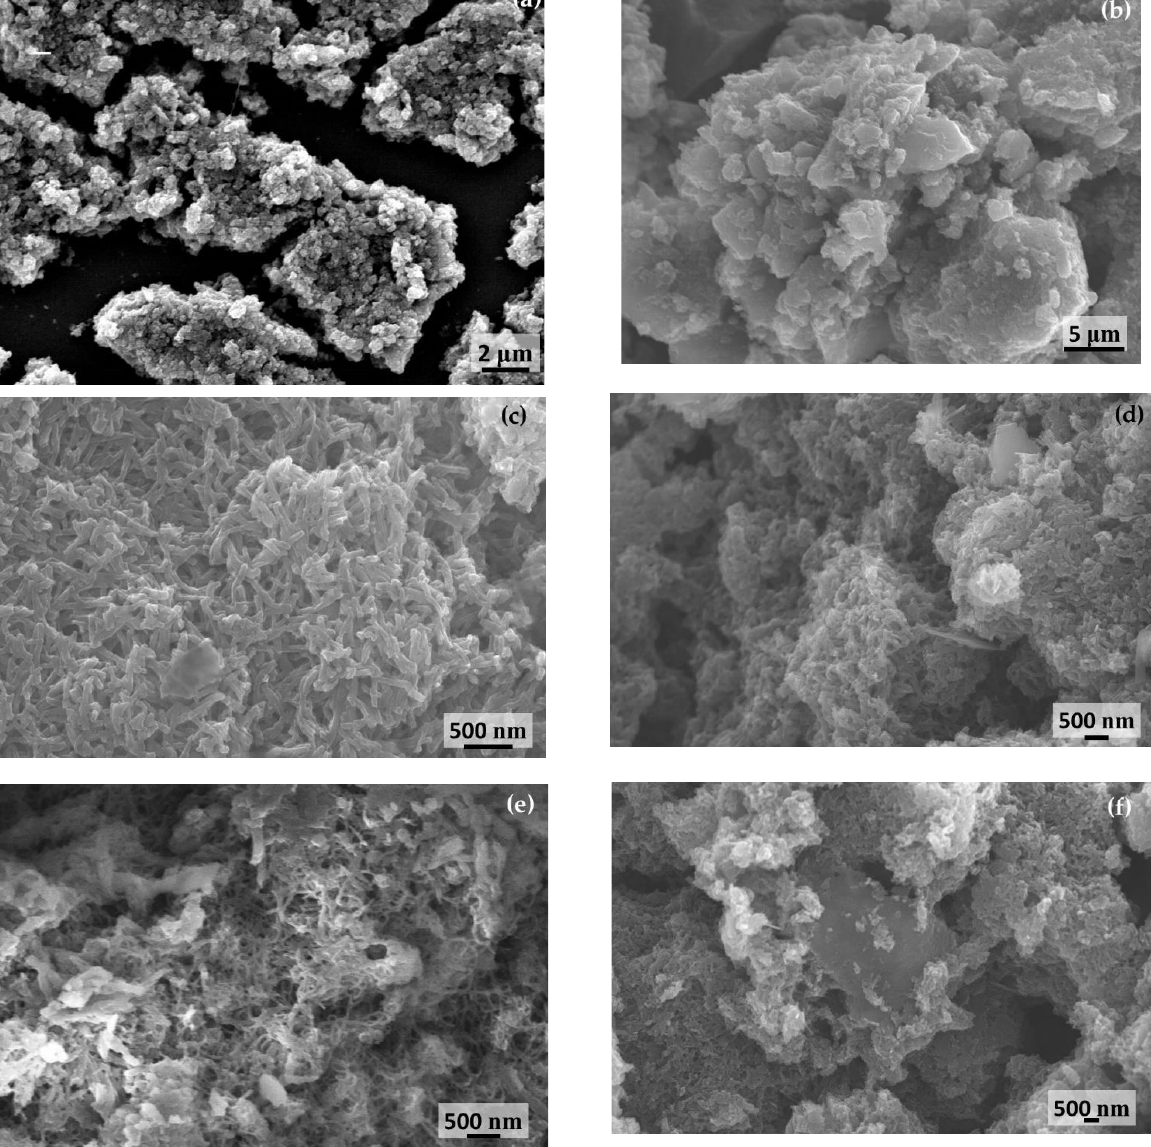
Figure 1. Scanning electron micrographs of ( a , b ) activated carbon (AC); ( d – f ) semi-polycrystalline polyaniline-activated carbon composite (SPani-AC).